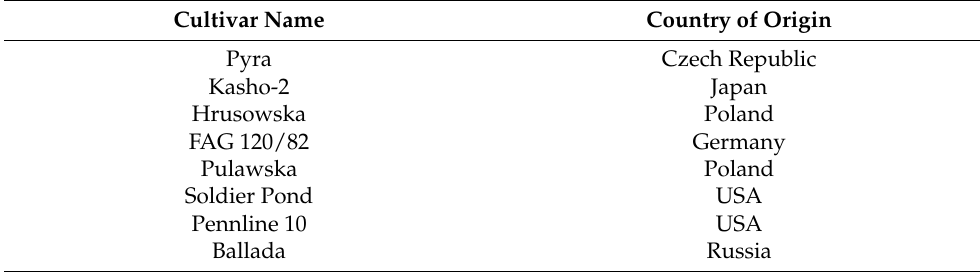
Table 7. The country of origin of the investigated buckwheat cultivars. Cultivar